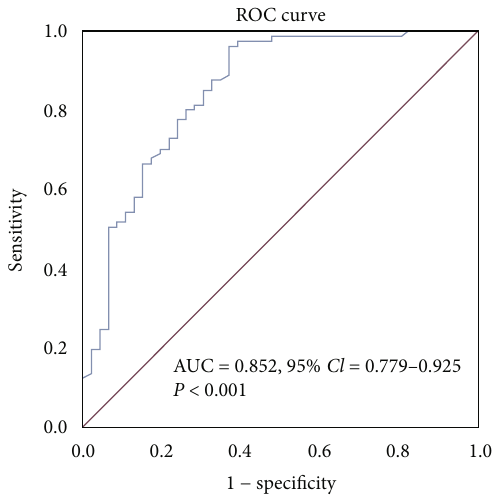
Figure 2: Receiver operating characteristics analysis. ROC curve was used to evaluate the discriminative capacity of TMAO for severe